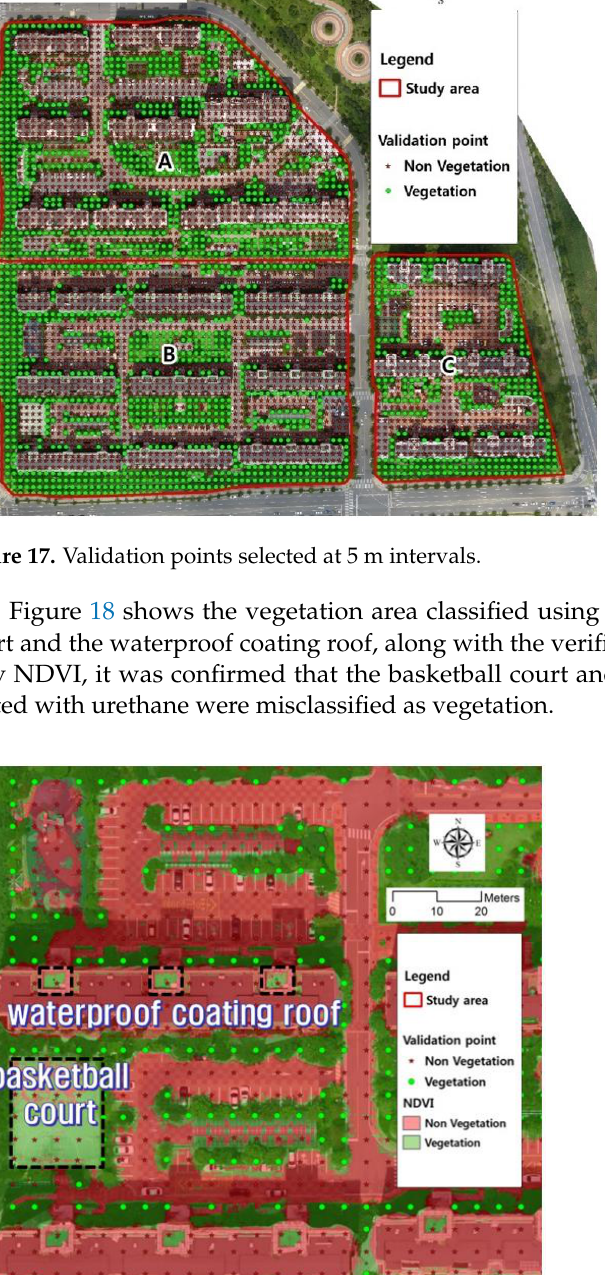
Figure 17. Validation points selected at 5 m intervals.